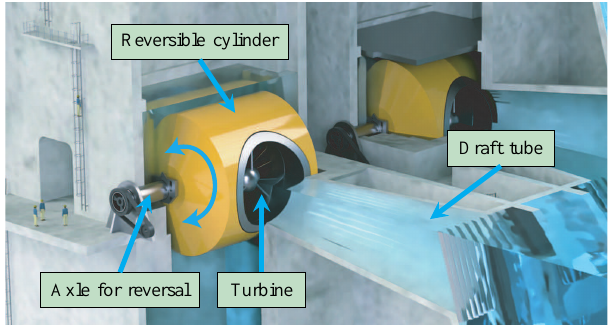
Fig. 2. Concept of the turbine that is installed in a reversible cylinder (Figure courtesy of Tidetec